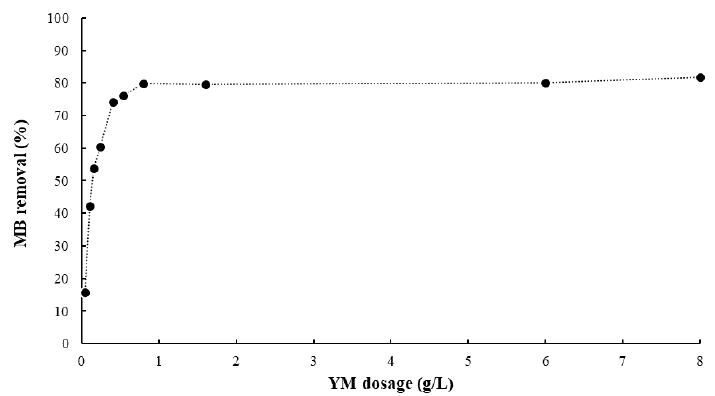
Figure 4. Methylene blue (MB) adsorption removal efficiency after 72 h of equilibrium tests at different YM dosages. Conditions: 20 mg/L of MB, 50 mL of volume, pH = 6 and 25 °C.